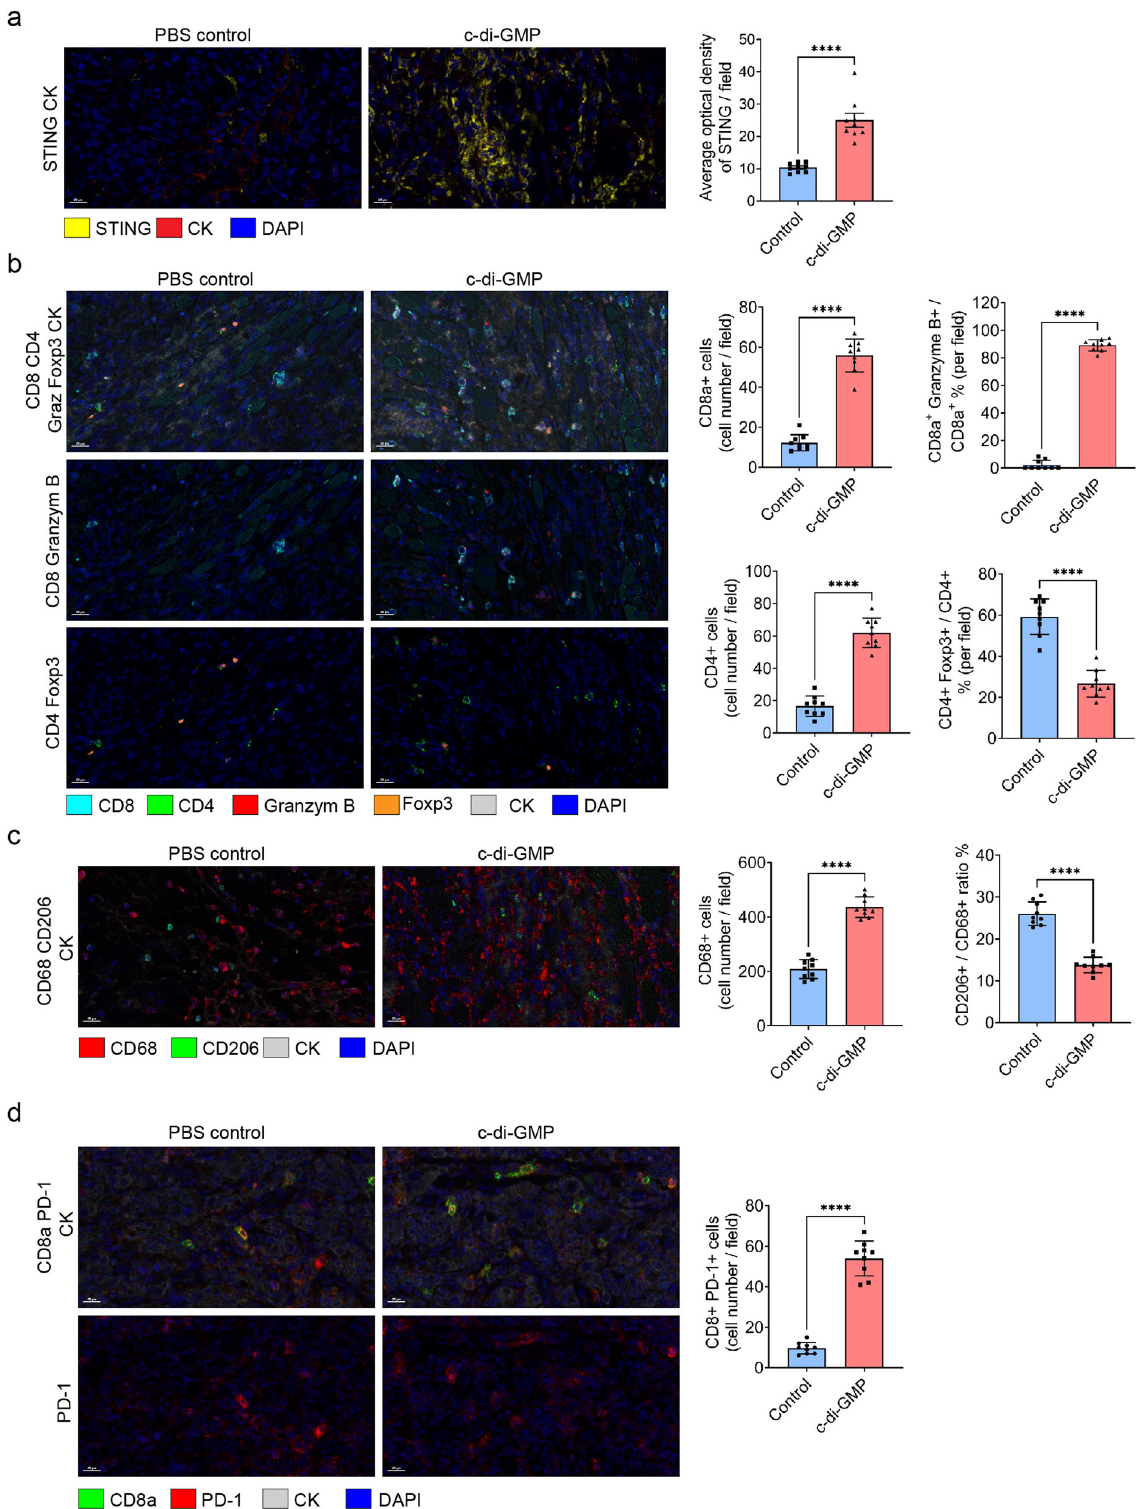
Fig. 7 STING agonist c-di-GMP in fl uences the TIME of ROC1 cold tumors. Fluorescent multiplex IHC quanti fi cation analysis shows that STING ( a ), T-lymphocyte markers (CD8a, CD4, granzyme B, and Foxp3; ( b )), macrophage markers (CD68 and CD206; ( c )), and PD-1 ( d ) are differentially expressed between STING agonist (c-di-GMP) and PBS control groups. Representative images were processed using phenochart 1.0.12 software (scale bars, 20 μ m). Multiplex IHC quanti fi cation was de fi ned as the average optical density per view and density of cells per view (×20 magni fi cation) and cellular density per fi eld was quanti fi ed using Image J software ( n = 3 slides and three random fi elds from each slide were quanti fi ed). Unpaired two-tailed Student ’ s t test showed the p -value = **** p <